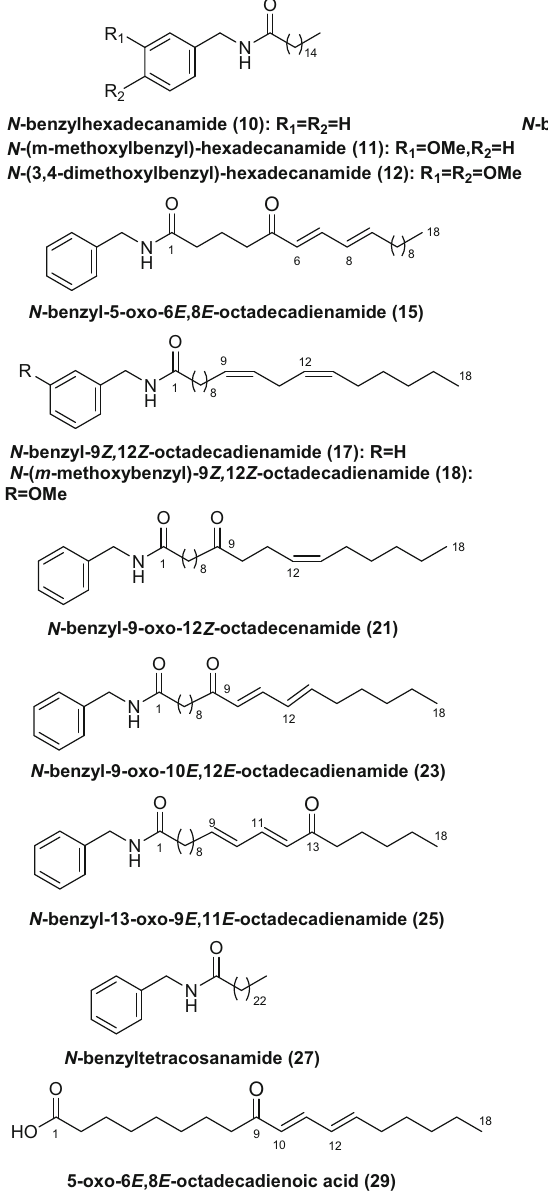
Fig. 2 Structures of macamides and macaenes found in